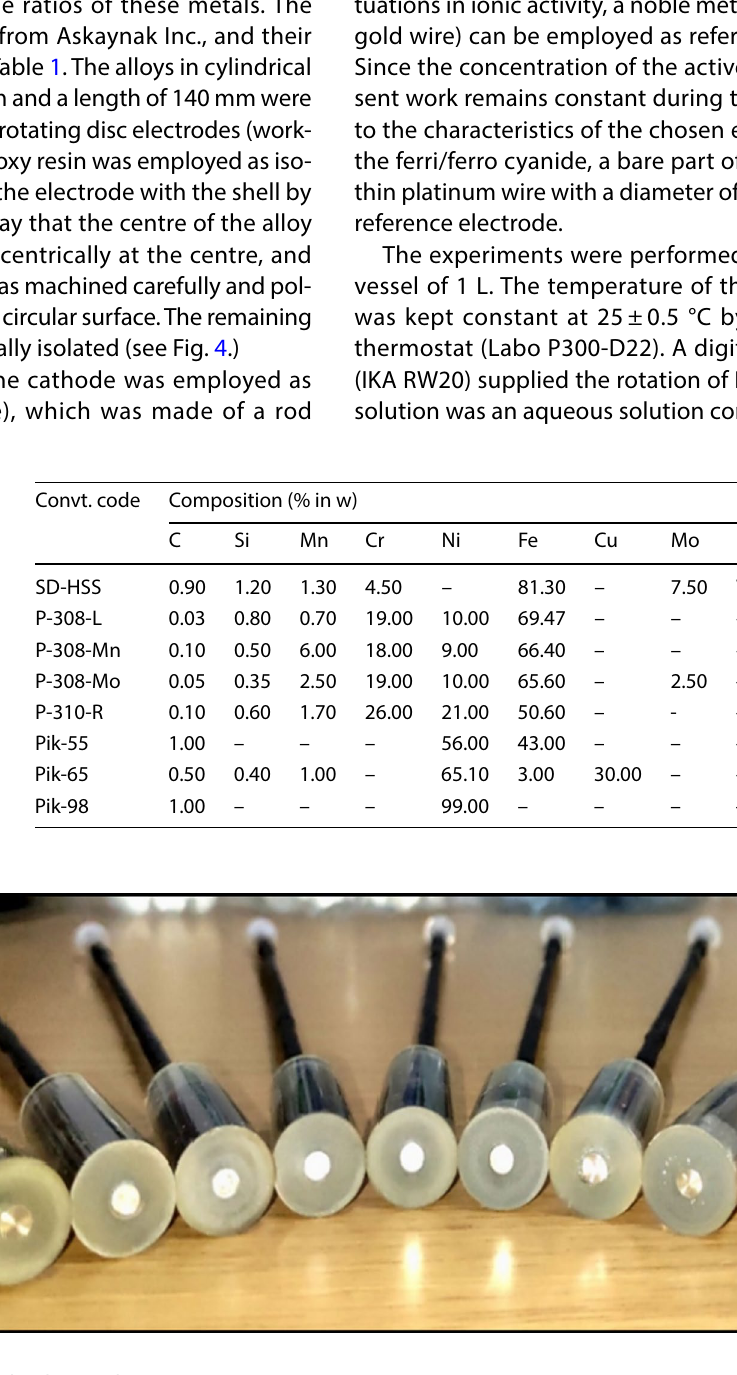
Fig. 4 Photos of working electrodes designed as